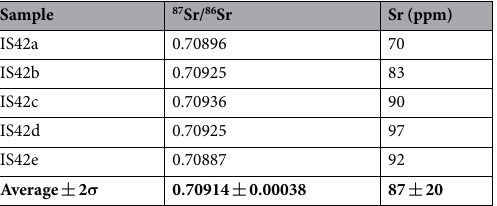
Table 1. LA–MC–ICPMS data of IS42 (deciduous human tooth) enamel. All 87 Sr/ 86 Sr 2SE (in-run error) are ≈ 0.00010. Sr concentration was estimated through linear interpolation from known standard materials during the analytical